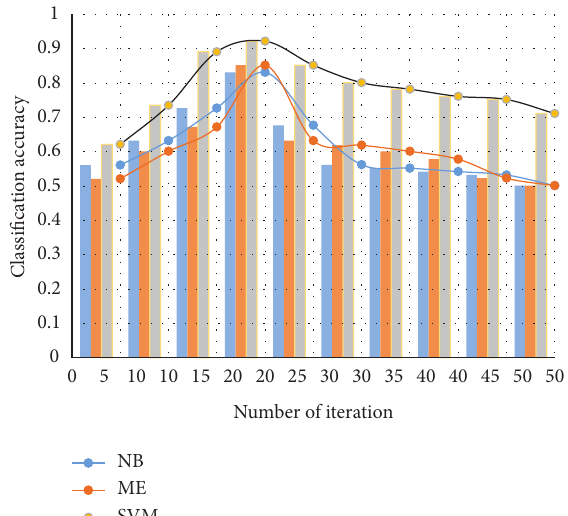
Figure 10: Performance comparison of lyrics-based music sentiment classification under the same sentiment